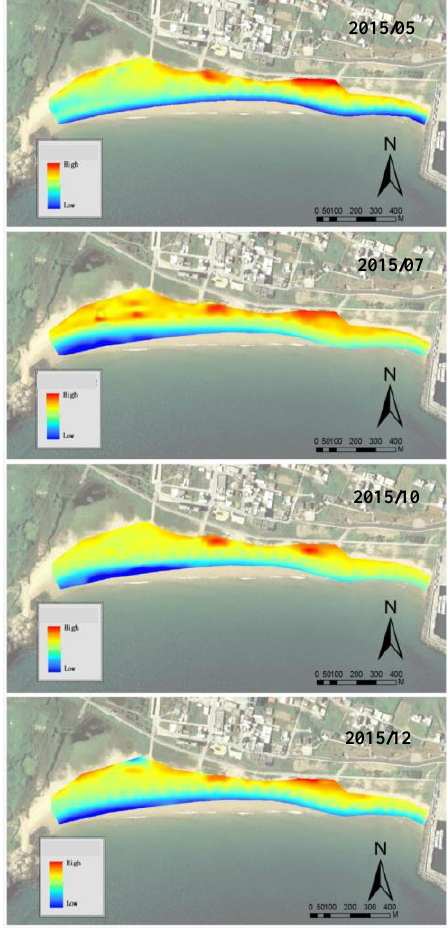
Figure 6. Multiple time series of beach